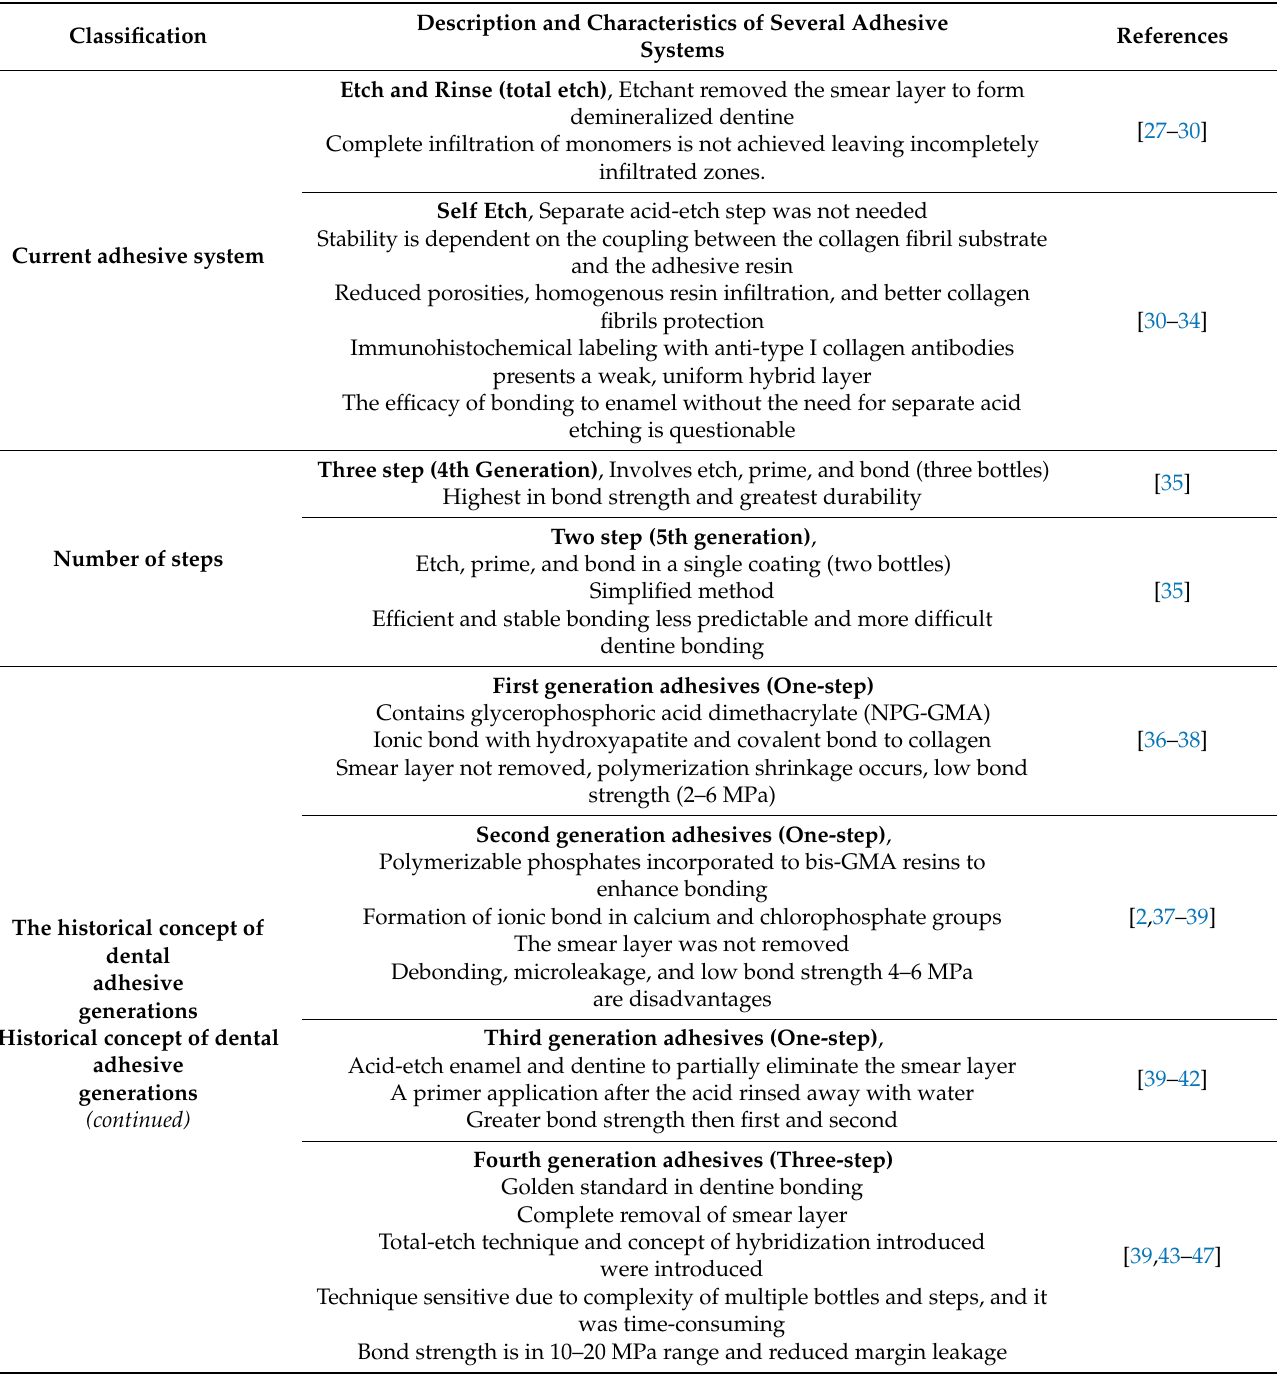
Table 2. Summary of the different classification systems used for categories of dental